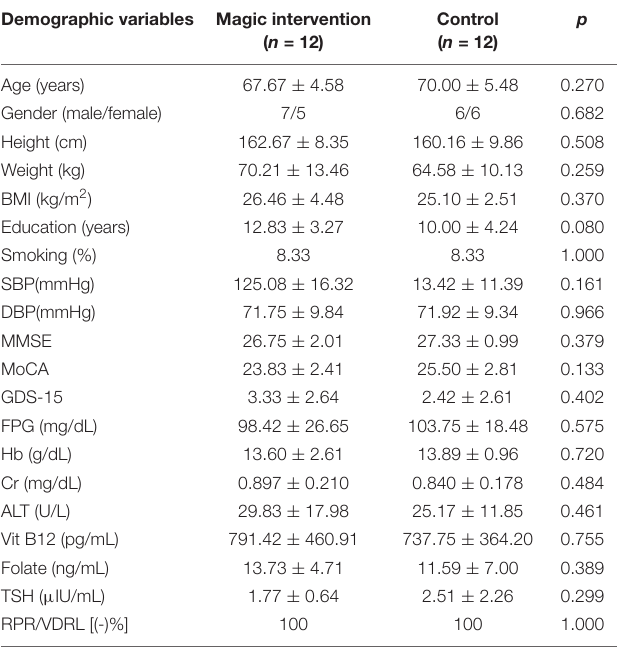
TABLE 2 | Demographic characteristics of the magic intervention group and control